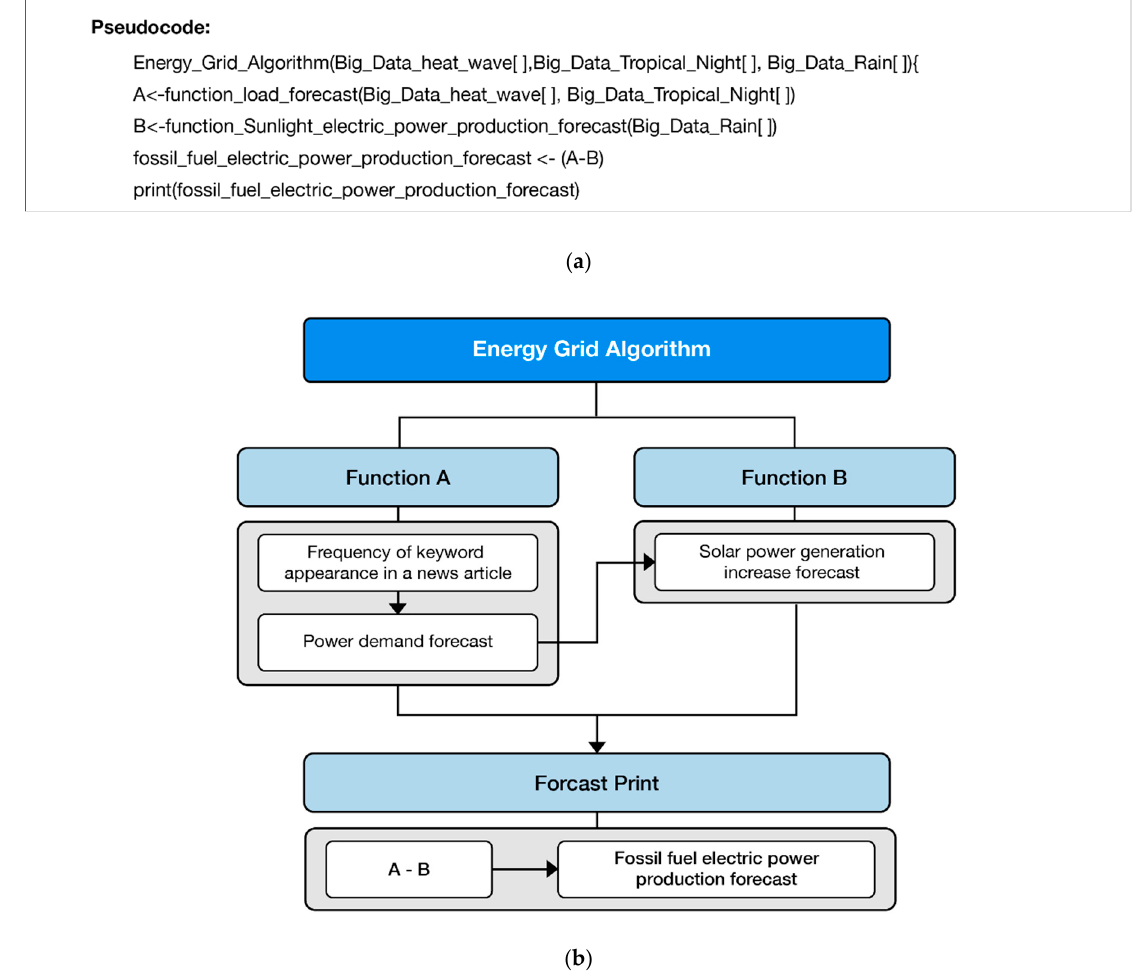
Figure 30. Pseudocode/flowchart of fossil fuel electric power production forecast. ( a ) Pseudocode of Fossil Fuel Electric Power Production Forecast. ( b ) A flowchart of the “energy grid algorithm” for fossil fuel electric power production fore- cast.